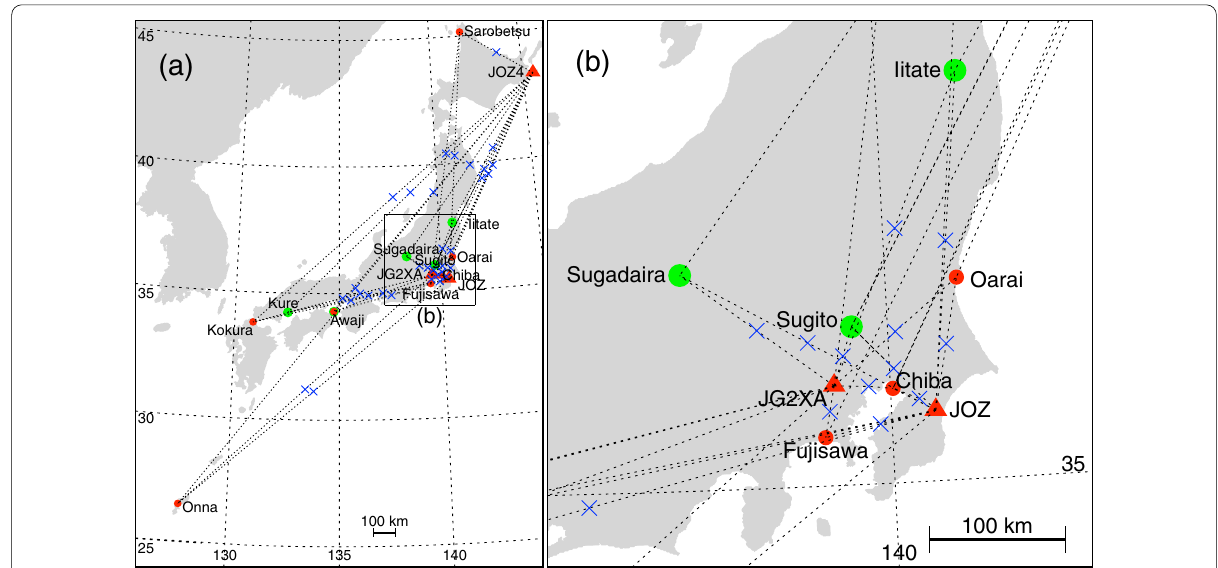
Fig. 1 a Locations of the transmitting and receiving stations of the HFD sounding system in Japan. The transmitting stations are indicated by the red triangles and the receiving stations are indicated by the circles. The color of the circles indicates the type of receiving system, i.e., green for the conventional analog receiving system and red for the new digital system. The middle points of the transmitters and the receivers are indicated by the blue cross marks. b An enlarged figure of the Kanto